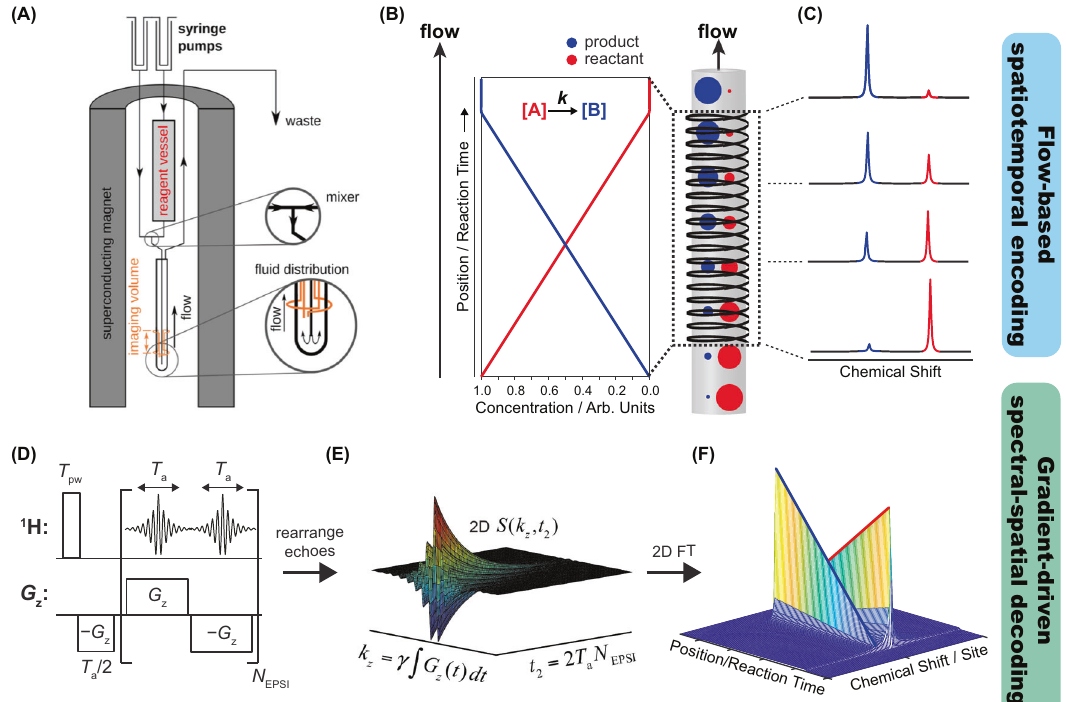
Fig. 1 Time-resolved kinetic 2D NMR spectrotemporal correlations arising by combining fl ow-based spatiotemporal encoding and gradient-driven spectroscopic imaging decoding. A Experimental setup for encoding off-equilibrium kinetics using rapid-mixing and continuous plug-like fl ow, incorporating a syringe-driven apparatus integrated with a gradient-equipped NMR fl ow probehead and high- fi eld NMR magnet. B Idealized plot of the time-dependent concentrations evolving from a reaction mixture characterized by a zero-order rate law, in which the depletion and formation of the reactant and product are linear functions in time. As this reaction mixture fl ows through the NMR coil, the plug-like fl ow encodes each position along the + z direction with a unique, steady-state proportion of reactant and product, as schematically indicated by the size of the red and blue circles, respectively. C Each position in space is therefore encoded with a unique NMR spectrum that corresponds to a distinct and de fi nite moment along the reaction process. D The echo-planar spectroscopic imaging (EPSI) pulse sequence is used to retrieve and decode the spatially-encoded kinetic information, by resolving NMR spectra as a function of position using an oscillating bipolar gradient-echo train. E , F Post-processing of the 1D EPSI time-domain dataset followed by Fourier transformation with respect to the imaging- and time-domain variables k z and t 2 , respectively, reveal the spatiotemporally-encoded kinetic NMR